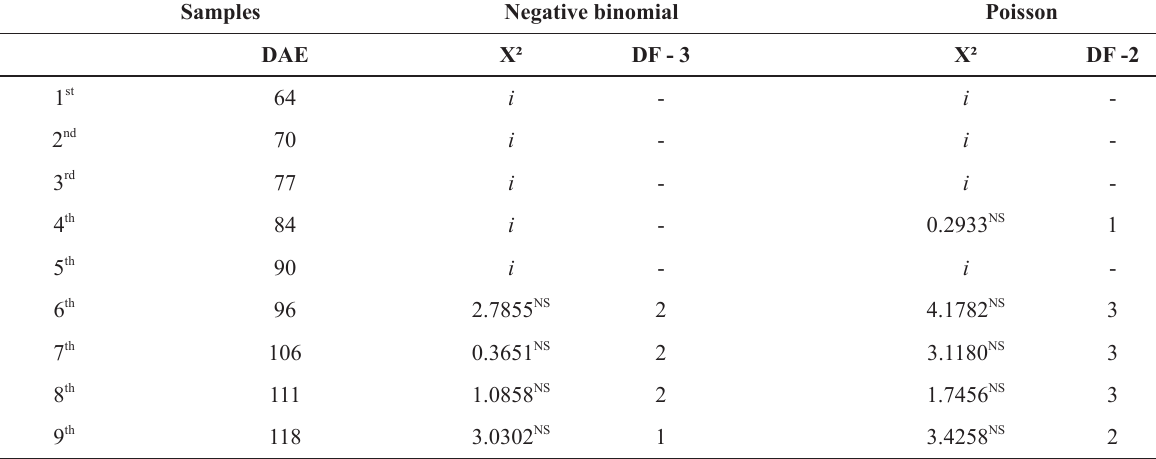
Chi-square goodness-of-fit test of the observed and expected frequencies of E . heros per plot and the Poisson and negative binomial distributions. Dourados - MS,